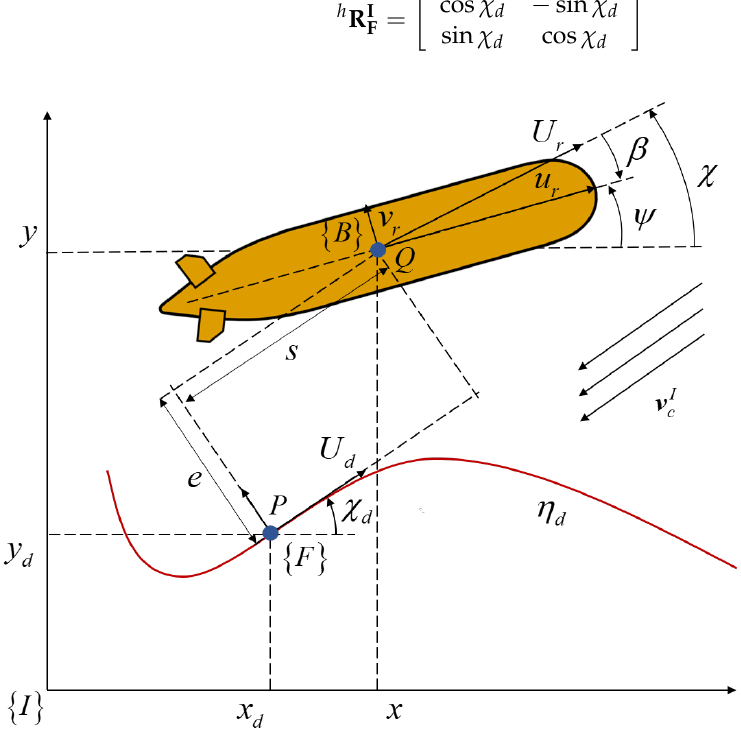
Figure 3. The definitions of trajectory tracking errors in the horizontal